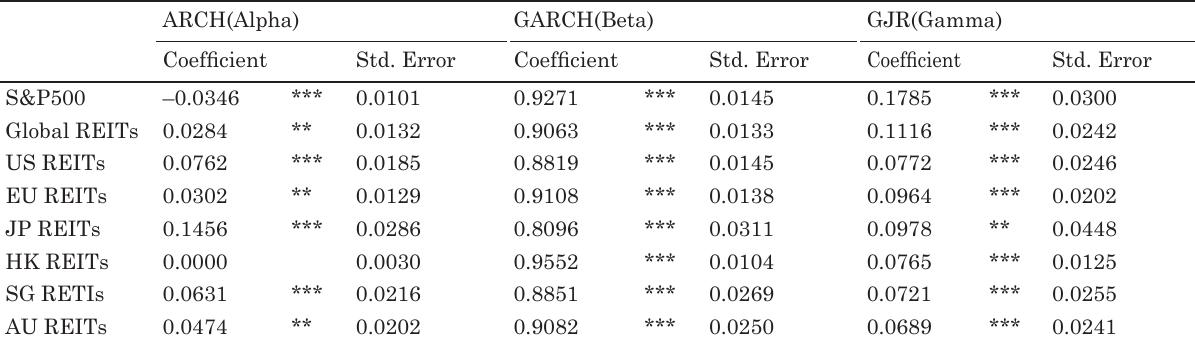
Table 3. The parameter estimates of the GJR-GARCH (1, 1) (sample period: